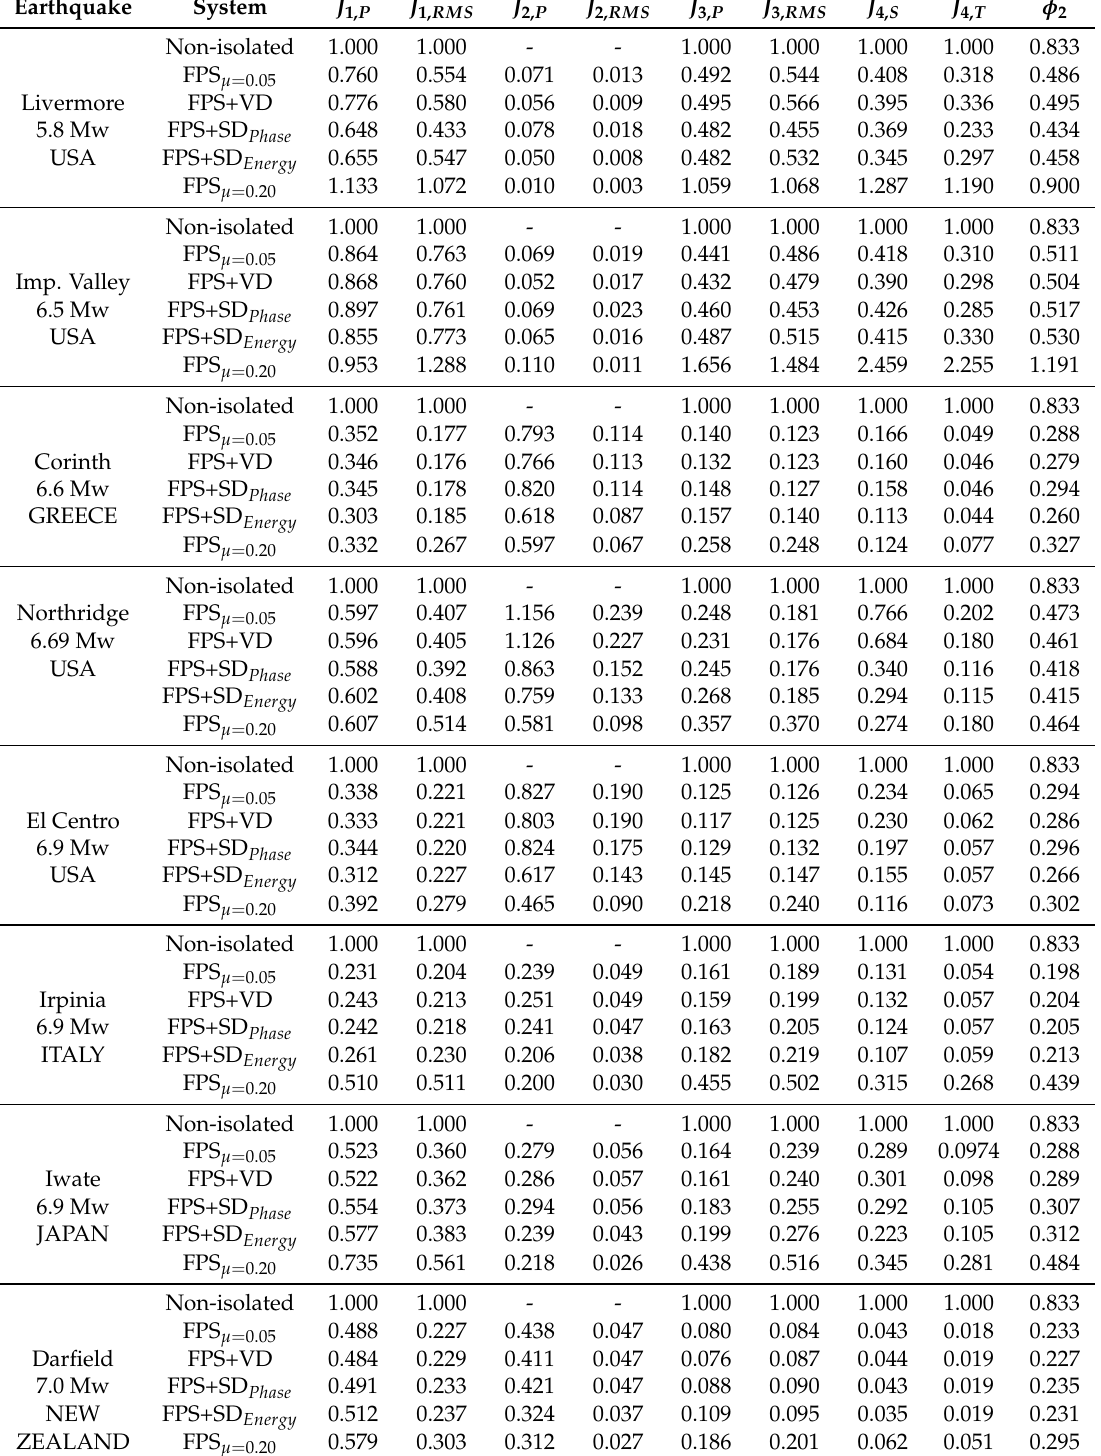
Table 4. Response under selected